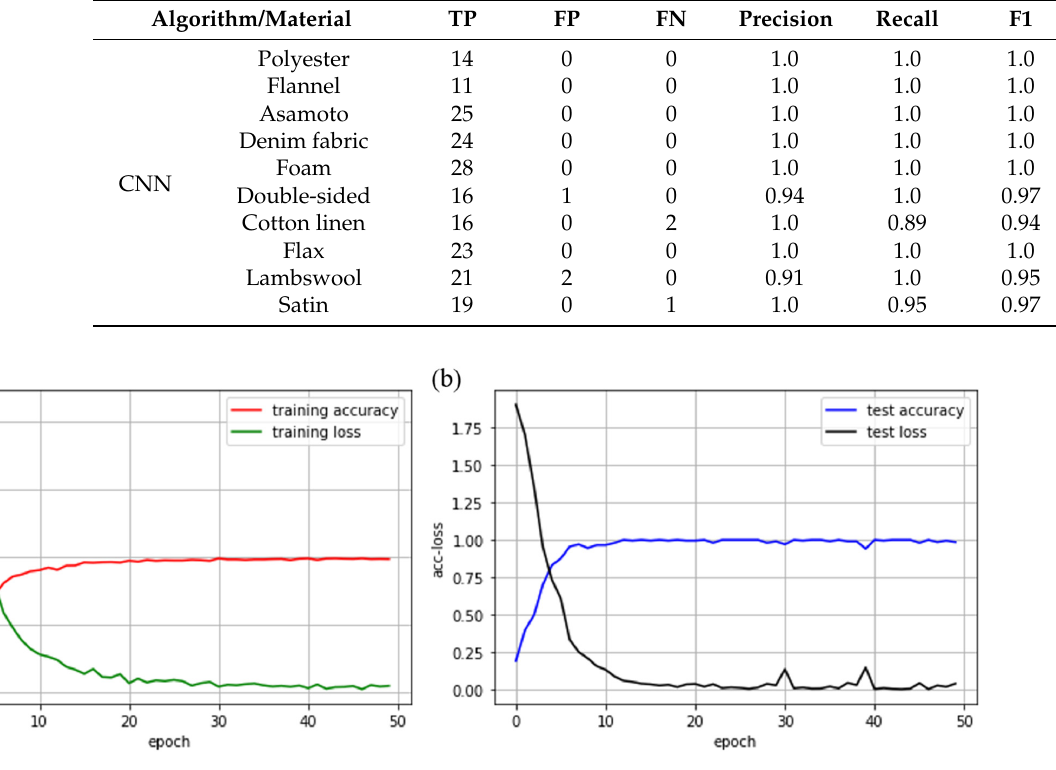
Figure 8. Training and test results of the convolutional neural network: ( a ) The change curve of training accuracy and training loss as the number of iterations increases; ( b ) the change curve of test accuracy and test loss as the number of iterations increases. Table 4. Recognition accuracy of four algorithms.